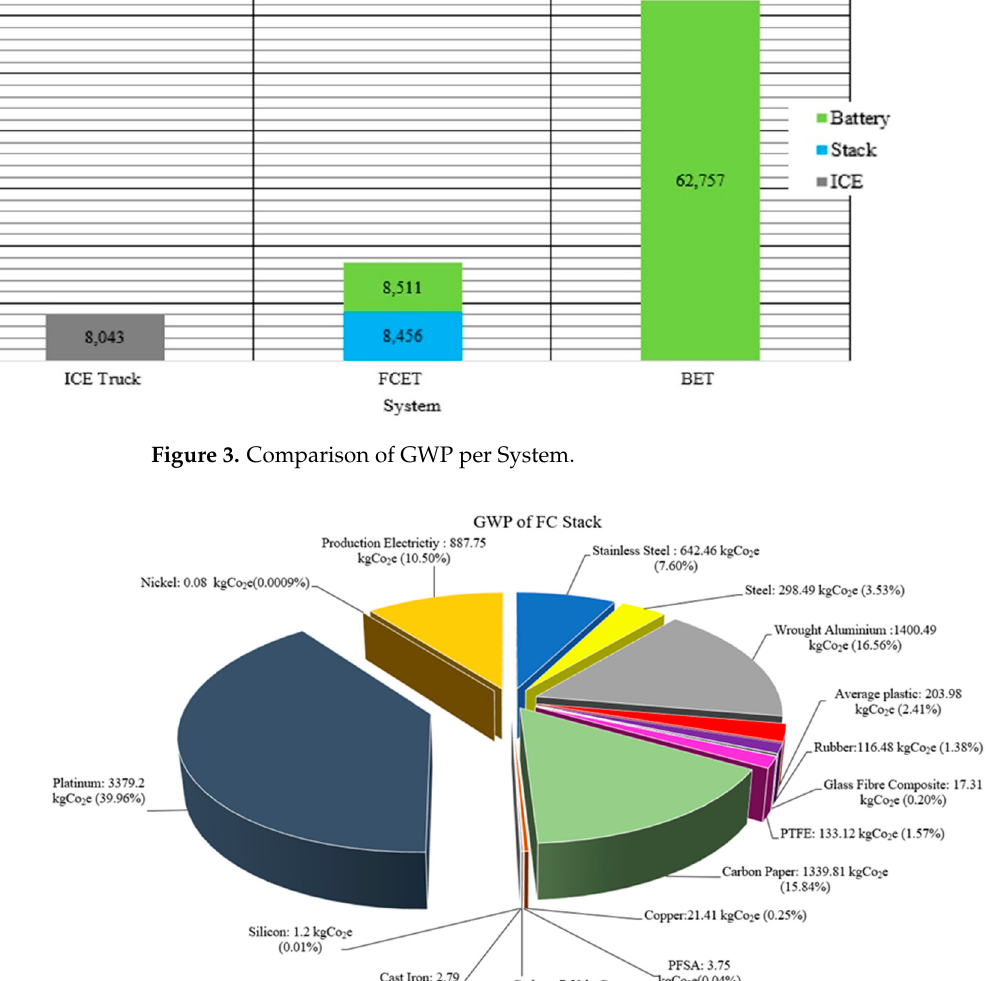
Figure 4. GWP contributions for FC stack. Abbreviations: Polytetrafluoroethylene (PTFE).